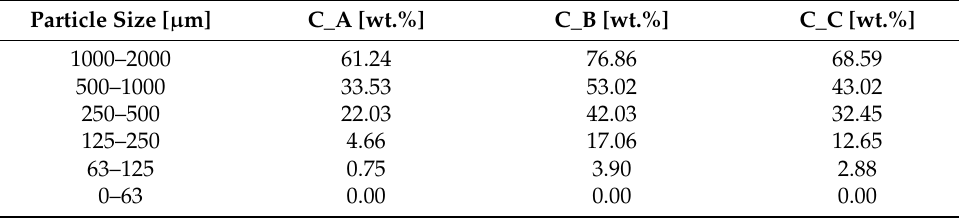
Table 2. Sieve analysis of used curves.